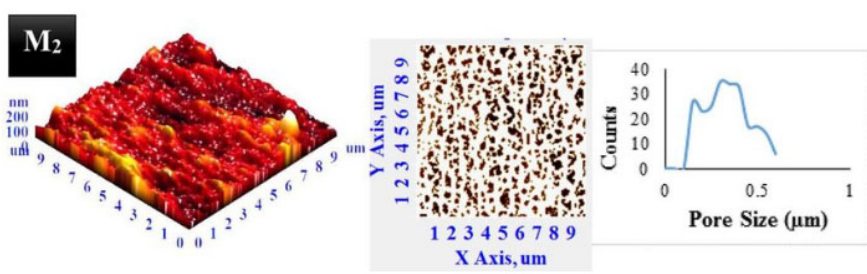
Figure 11. Determination of pore size distribution of polyvinylidene fluoride (PVDF) membrane by analyzing the 3D image generated by AFM [50]. Membranes 2020 , 10 , 33 10 of 37